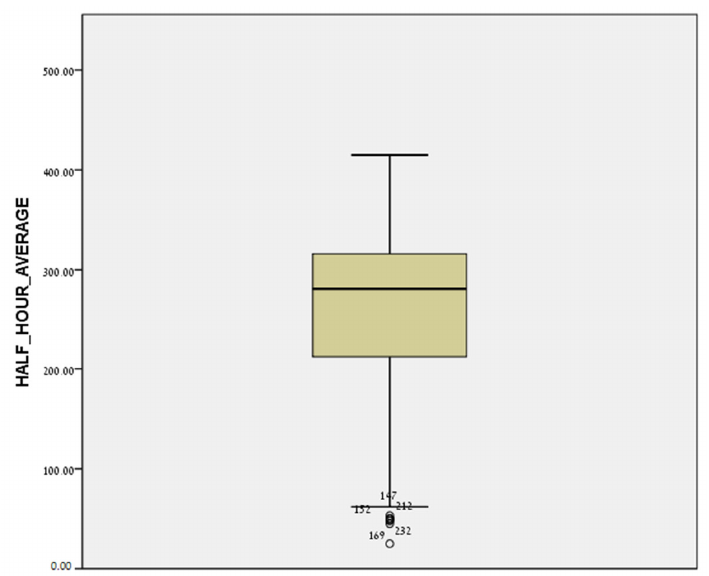
Figure 2. Distribution of NOx concentrations at the participants’ residential addresses (Box ‐ plot diagram).